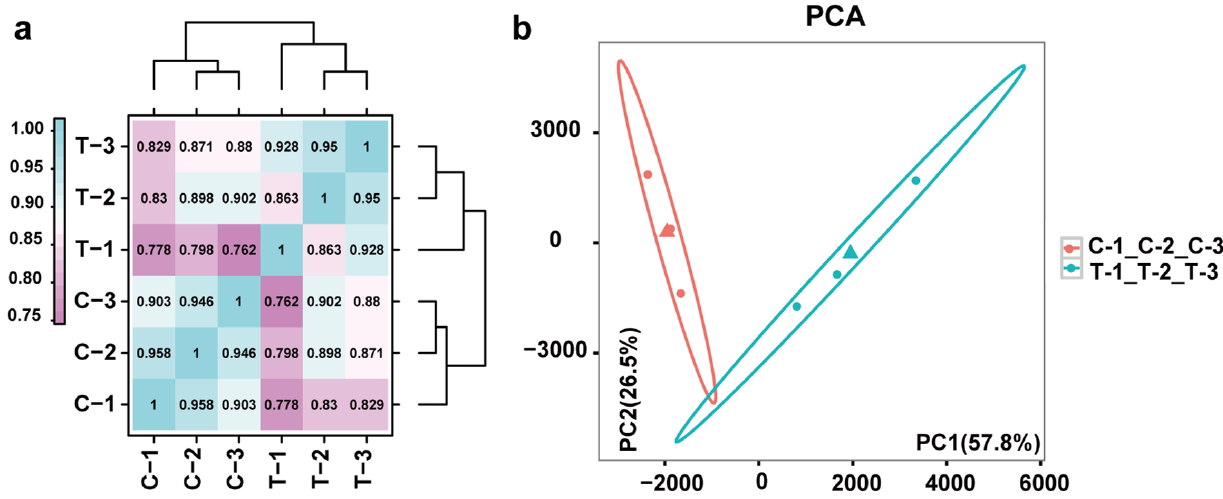
Figure 2. General analysis of the transcriptome data of samples following water and ethephon treatments. Pearson’s correlation analysis ( a ) and principal component analysis (PCA) ( b ) between six samples. x- and y-axes represent each sample. C-1, C-2, and C-3 indicate three control samples. T-1, T-2, and T-3 represent three ethephon-treated samples.